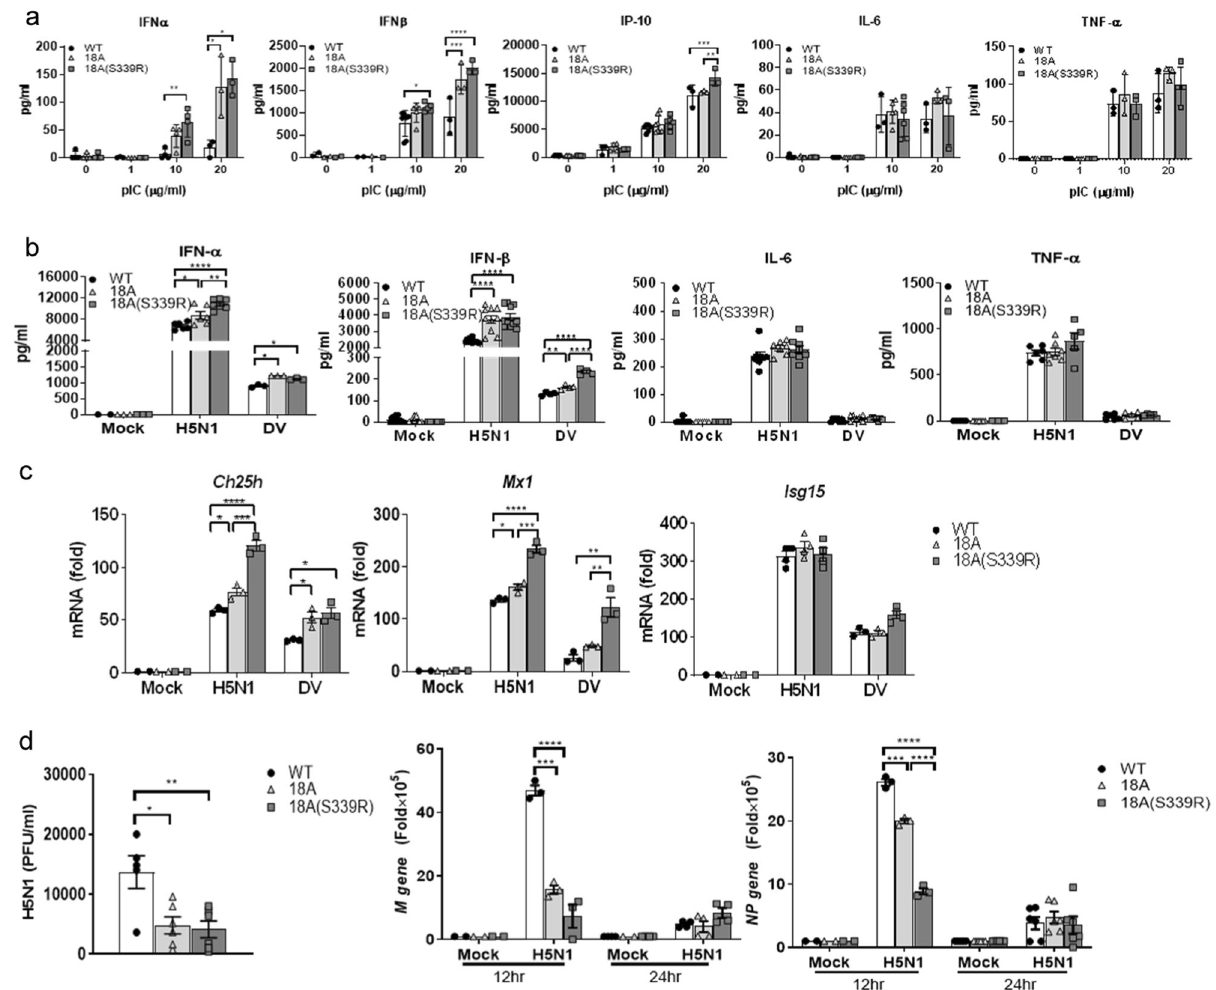
Fig. 2 CLEC18 enhances IFN production and ISG expression to suppress virus replication. a BMDMs (1 × 10 6 /well) from WT, ROSA-CLEC18A, and ROSA-CLEC18A(S339R) mice were incubated with HMW poly (I:C) for 24 h, followed by harvesting cells to determine the expression of cytokines by ELISA ( n = 3 – 6). b , c BMDMs (1 × 10 6 /well) from WT, ROSA-CLEC18A, and ROSA-CLEC18A(S339R) mice were incubated with RNA viruses (H5N1 MOI = 2; DV MOI = 30) for 24 h, followed by harvesting cells to determine cytokines expression by ELISA ( n = 3 – 10) ( b ) and IFN-stimulating genes (ISG) expression by quantitative RT-PCR ( n = 3) ( c ). d Virus replication was determined by plaque assay (left), and quantitative RT-PCR to determine the expression of virus structure genes (M) and nucleoprotein (NP) (right) ( n = 3 – 10). One-way ANOVA was performed. * P < 0.05, ** P < 0.01, *** P < 0.001 and **** P < 0.0001, for WT group versus group of CLEC18A or CLEC18A(S339R). H5N1 type A in fl uenza virus, DV dengue